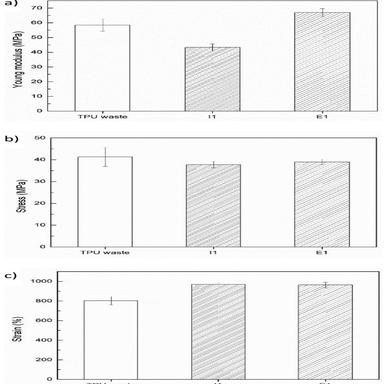
Mechanical properties of TPU waste, E1 and I1: a) Young modulus, b) stress and c) strain.